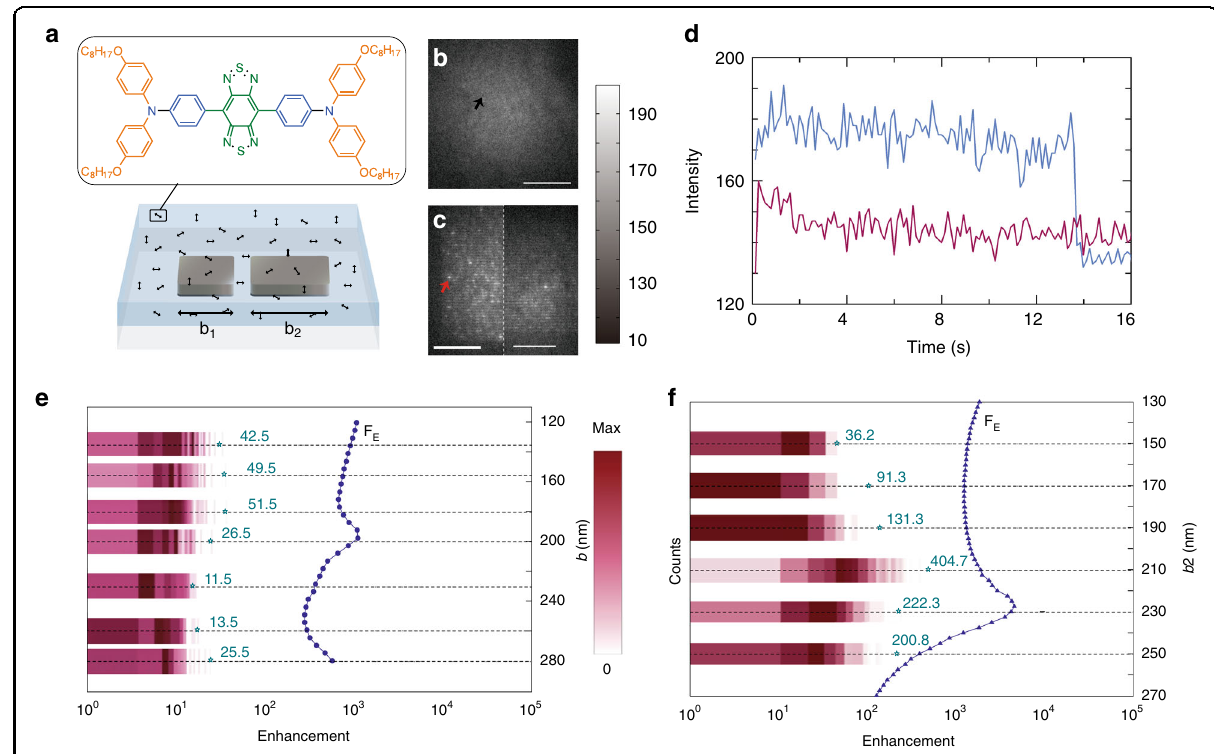
Fig. 2 Experimental setup and measurement of F E for single AIEE1000 molecule. a Schematic of double-bar nano-antenna (with bar length b 1 and b 2 ) coated with AIEE1000 molecules (black double ended arrows) in PMMA (light blue) on glass substrate (light gray). Inset shows the chemical structure of AIEE1000. b Fluorescence image of AIEE1000 in PMMA without antennas. Scale bar, 10 µm. Data are collected when excitation power density is 32 kW/cm 2 , and are rescaled for direct comparison with image in Fig. 2c. c Fluorescence image of asymmetric antenna array (left) and symmetric antenna array (right) coated with AIEE1000 in PMMA. Data are collected when excitation power density is 32 kW/cm 2 . Scale bar, 10 µm. d Fluorescence time traces of a single pixel as arrows indicated in b (red curve) and c (blue curve). e Histograms of F E with symmetric double-bar antennas. Each histogram shows the distribution of fl uorescence enhancement from molecules near symmetric double-bar antennas with bar-length ranging from 135 nm to 280 nm. Maximums of simulated F E are plotted with blue dash-dotted lines. f Histograms of F E with asymmetric double-bar antennas. Each histogram shows the distribution of fl uorescence enhancement coming from molecules near asymmetric double-bar antenna with b 1 fi xed at 150 nm and b 2 varying from 150 nm to 250 nm. Maximums of simulated FE are plotted with blue dash-dotted lines, consisting with corresponding experimental results. The histograms in e , f are normalized with the maximum counts of enhancement for each experiment case, where the exact number of “ max ” are totally different for each